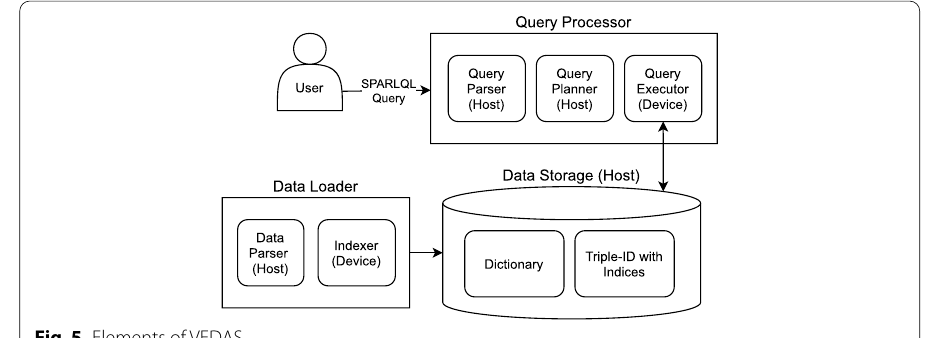
Fig. 5 Elements of